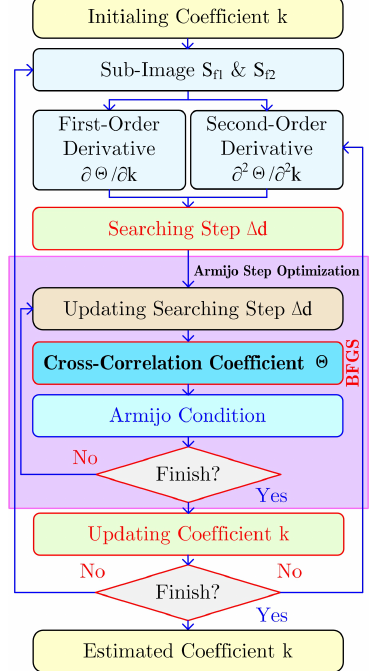
Figure 4. The procedure of proposed maximum optimization problem